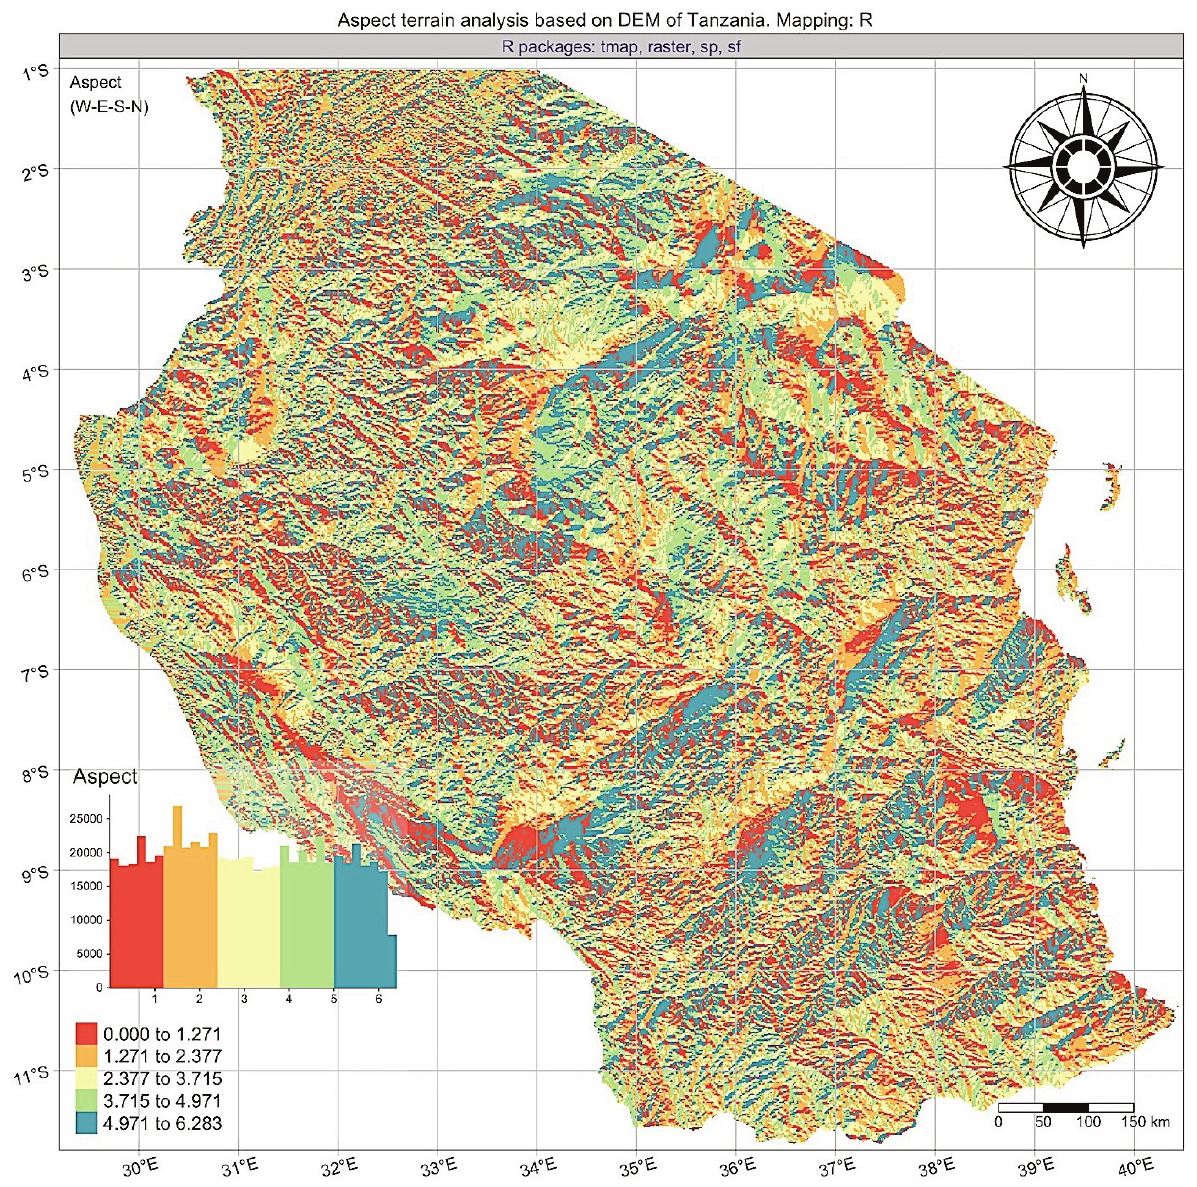
Fig. 7. Aspect terrain visualization based on DEM of Tanzania. Mapping by R using packages ‘tmap’, ‘raster’, ‘sp’, ‘sf’. Map source: elaborated by the